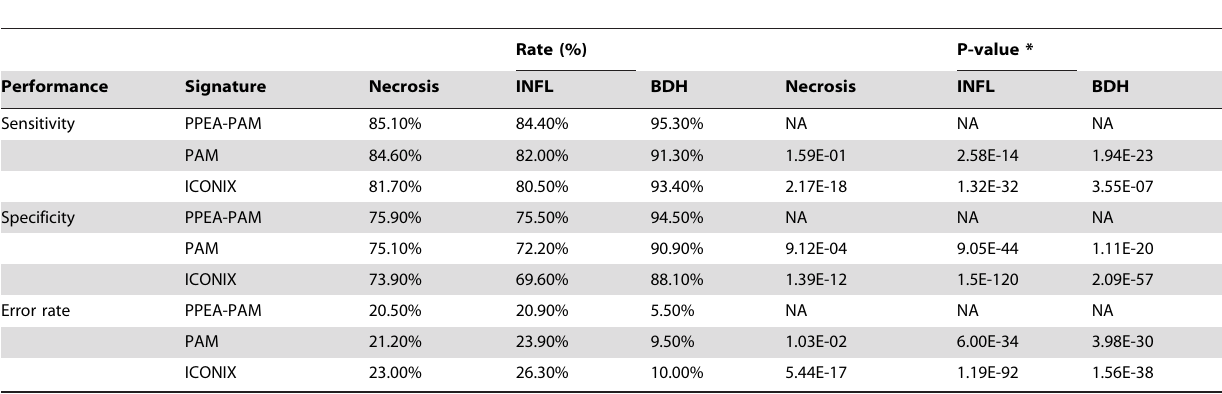
Table 1. A comparison of the performance of 3 different signatures for detecting Necrosis, Bile Duct Hyperplasia, and Inflammation.